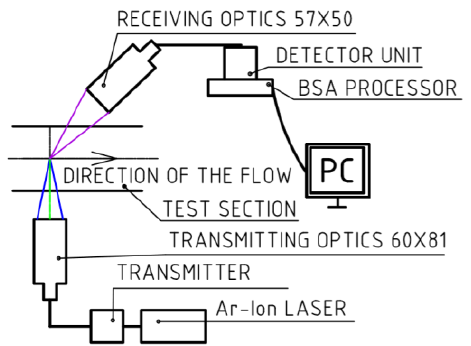
Fig. 2. PDA experimental setup